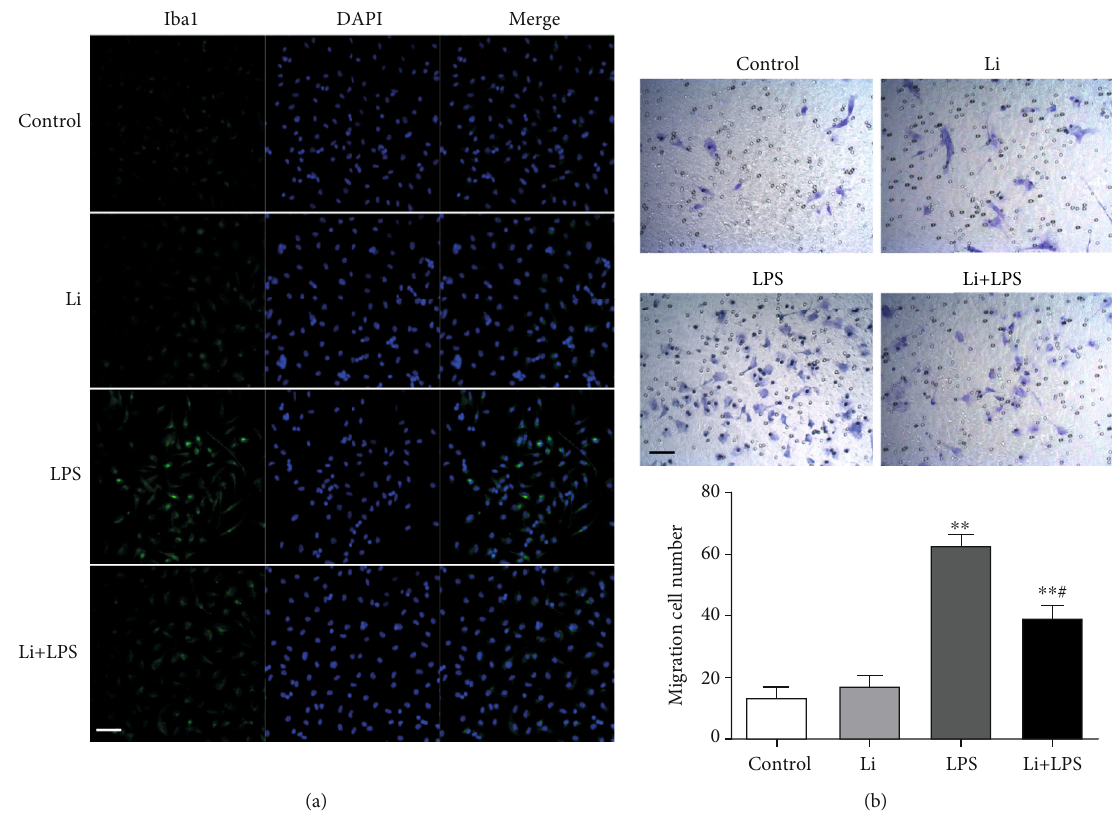
Figure 5: LPS-induced microglia activation and migration are suppressed by GSK-3 β inhibition in vitro . The primary microglia were pretreated with LiCl (1 mM) for 30 min and then incubated with LPS (10 ng/ml) for 24h. (a) Activation of primary microglia was examined using immuno fl uorescence. The microglia cells were stained with Iba1 antibody. Expression of Iba1 expression ( green ) in activated microglia was visualized by confocal microscopy. The blue staining represents DAPI. Scale bar = 50 μ m . (b) Crystal violet staining of primary microglia that migrated into the lower surface of the polycarbonate membrane inserts (8 μ m pore size) at 24 h after seeding. Scale bar = 50 μ m . Graph demonstrates the average number of migrating cells per visual fi eld in six random fi elds. The data are presented as means ± s : e : m : ( n = 3 ). ∗ P < 0 : 05 and ∗∗ P < 0 : 01 compared with the control group. # P < 0 : 05 compared with the LPS